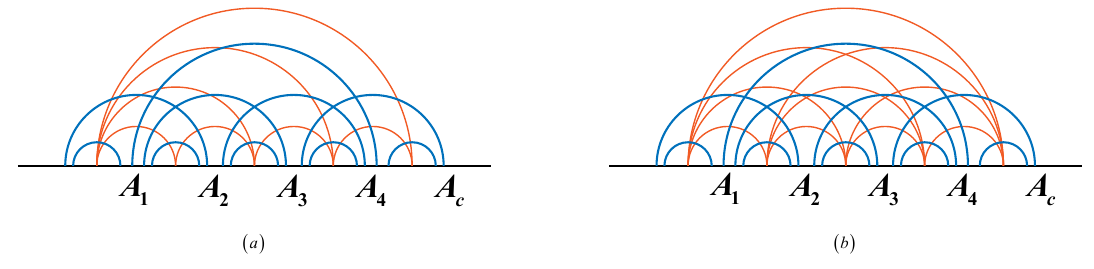
Figure 5 . The locking thread configuration for the case that the subregion A is divided into 4 parts. There are 10 independent component flows (denoted by blue lines) necessarily. (a) is the non-crossing type locking thread configuration, in which there are only 7 RT surfaces (denoted by red lines) involved. In (b), we propose a natural scheme to add more RT surfaces so as to match the number of the component